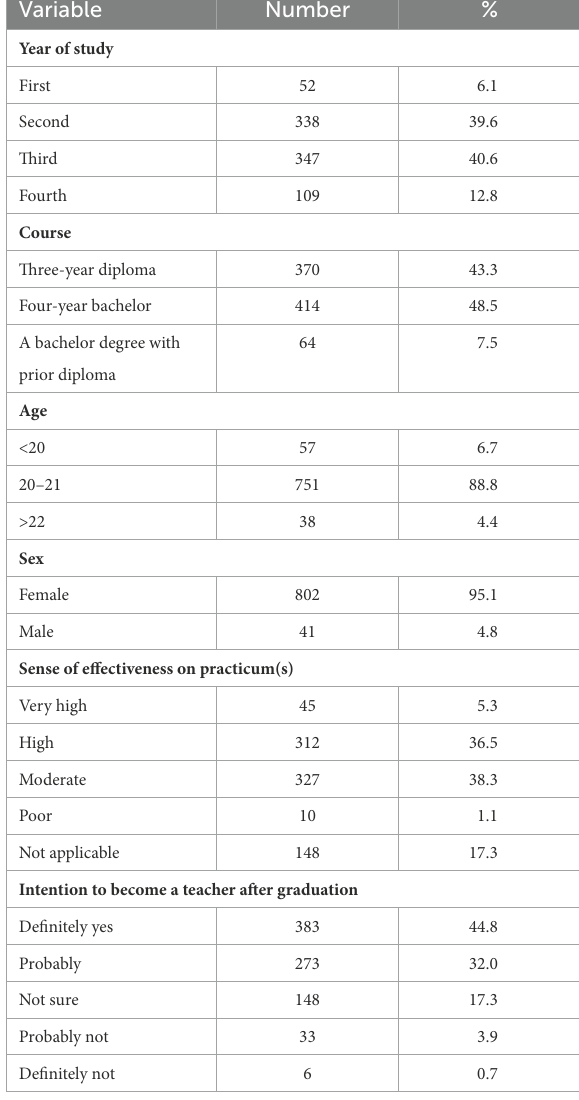
TABLE 1 Background characteristics of participants ( N = 854) a